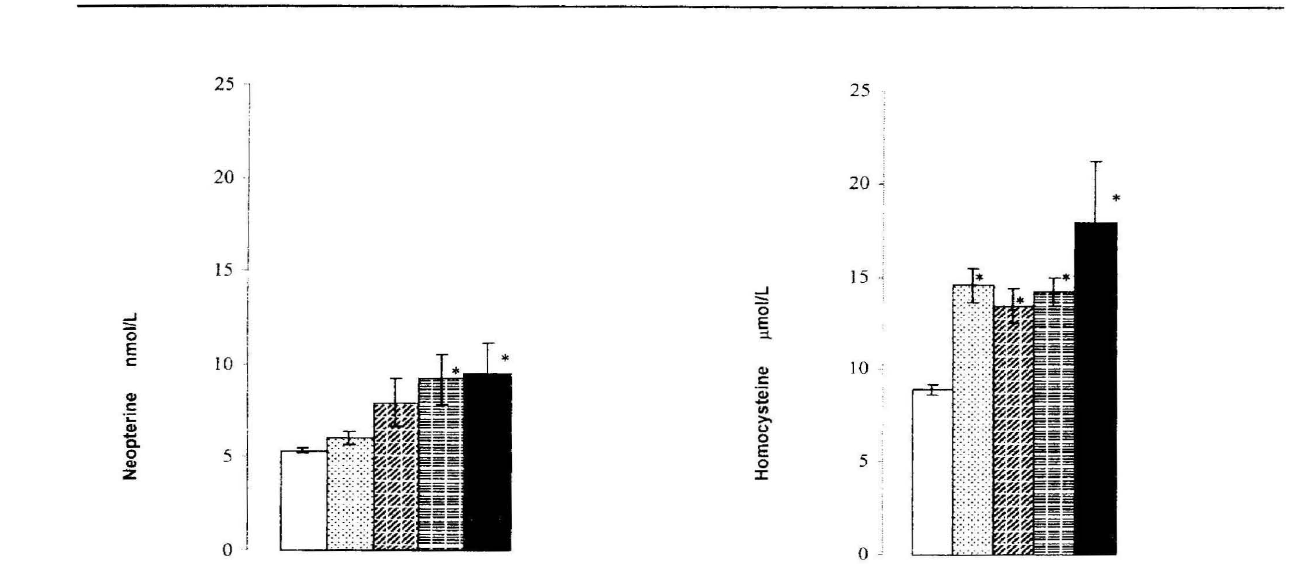
Figure 1. Concentrations (mean ± S.E.) of semm neopterin and homocysteine in healthy individuals (open bars) and in CHD patients before PTCA due to balloon angioplasty (dotted bars), 1" time stent implantation (hatched bars), repeated stent implantation (striped bars) and restenosis (black bars).*The changes are statistically signifi cant (P <0.01 - P <0.001).